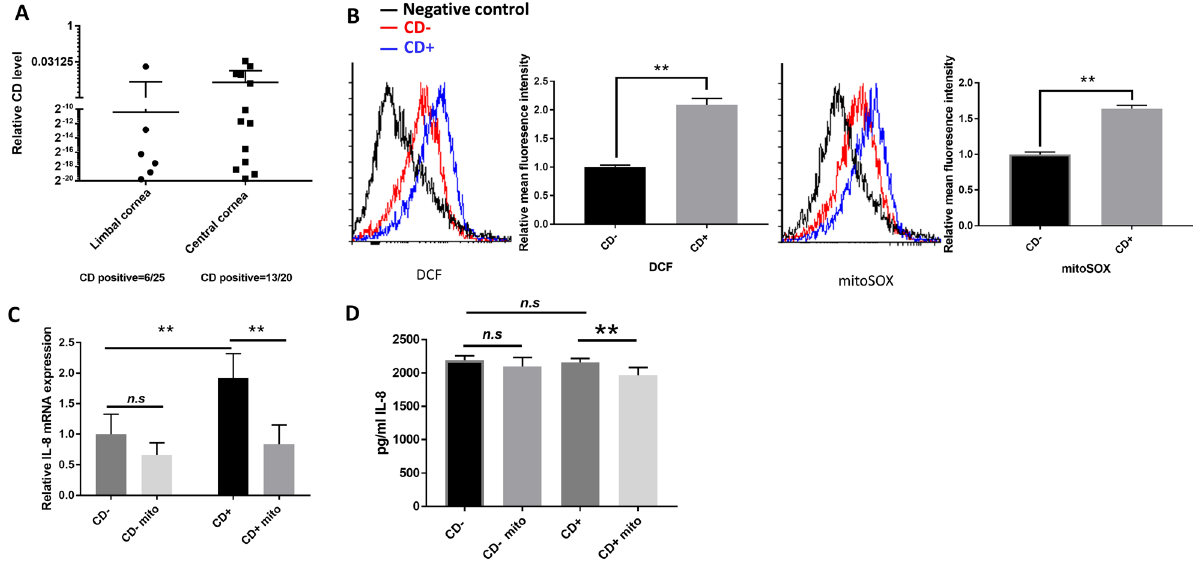
Figure 1. Oxidative stress in CD+ keratocytes up-regulates the IL-8 expression. ( A ) CD/total mtDNA ratios in 45 human subjects quantified by multiplex-qPCR. 26 values were zero and are not included on the graph. ( B ) Flow cytometric detection of DCFH-DA and mitoSOX signal in CD+/− keratocytes ( n = 3 ). ( C ) mRNA expression of IL-8 in CD+/− keratocytes. Cells either treated with 10 μM mitoTEMPO (Mito), or not, for 24 h ( n = 3). ( D ) Quantification of secreted IL-8 level using ELISA. Cells treated, or not treated, with 10 μM mitoTEMPO for 24 h ( n = 3). Values are means ± SD. n.s. (not significant); *P < 0.05, **P <